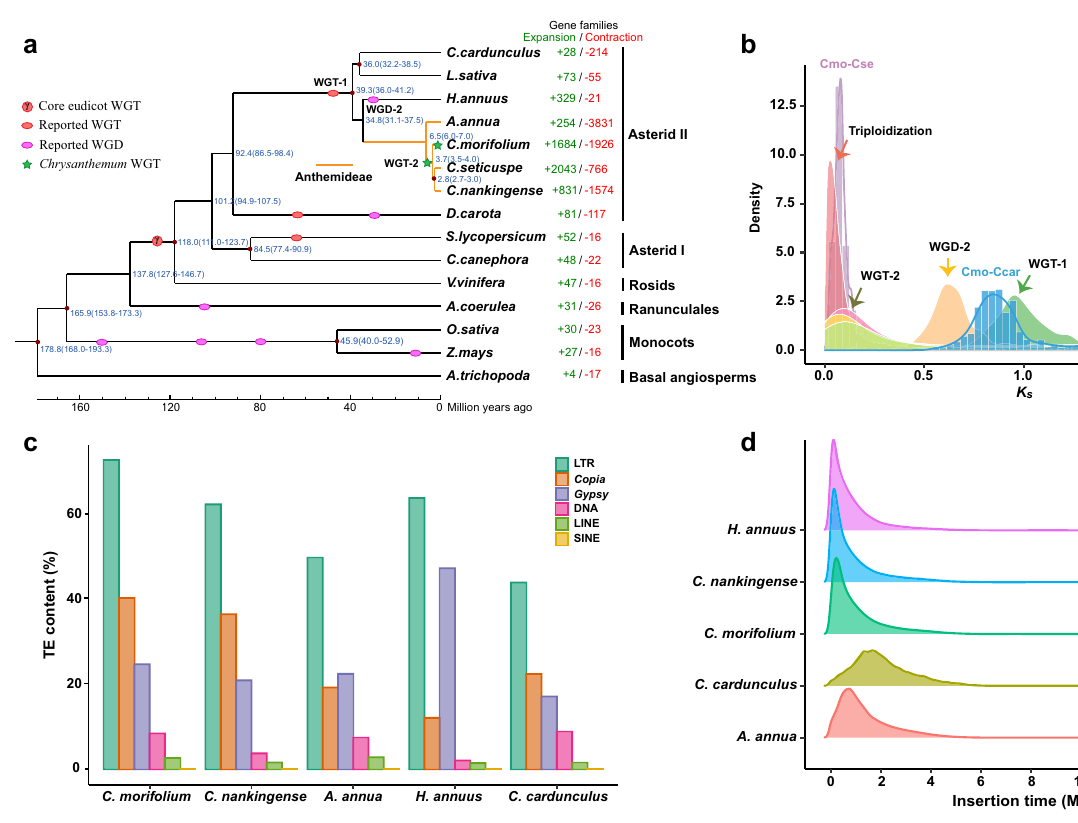
Fig. 2 | Genome evolution of C. morifolium . a Phylogenetic tree showing the evolutionaryrelationshipofcultivatedchrysanthemumand14other fl owingplants. Expansion (green) and contraction (red) of gene family numbers are shown on the right. The red circleson some nodes represent fossilcalibrations points, obtaining from the TIMETREE website (http://www.timetree.org/) 112 . Predicted divergence times (Mya, million years ago) are labelled in blue at other intermediate nodes as estimated by Maximum Likelihood (PAML), and the numbers in parentheses are